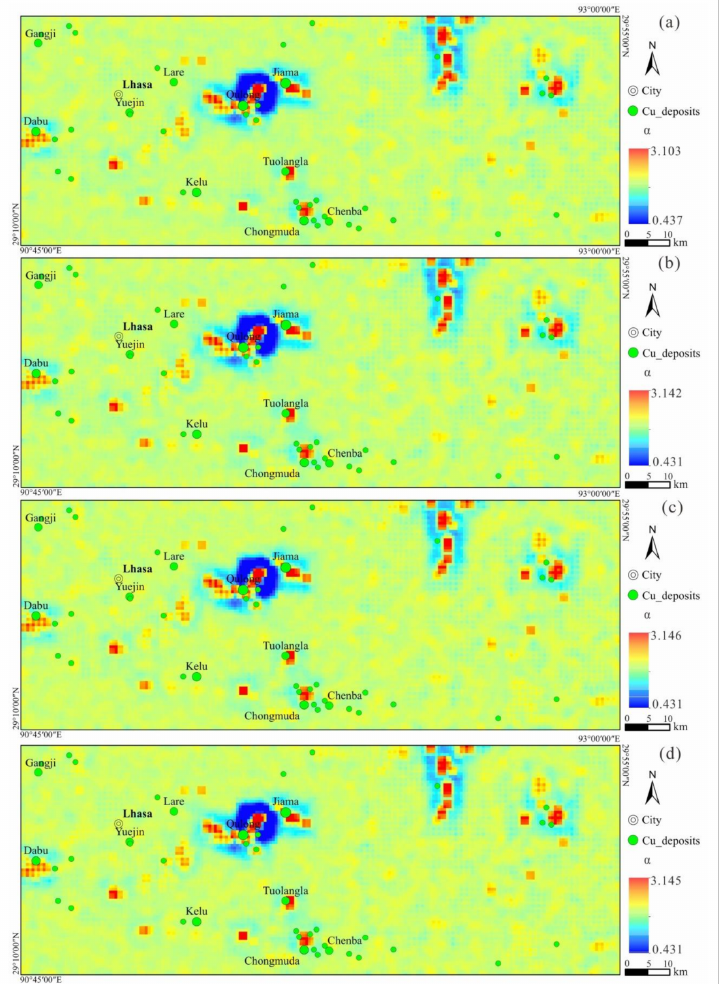
Figure 8. Corresponding local singularity analysis results of the four realizations: ( a ) LSA #15, ( b ) LSA #58, ( c ) LSA #130, and ( d ) LSA #186. All results of corresponding LSA associated with realizations can represent the uncer- tainty of local singularity, which is propagated from unsampled locations